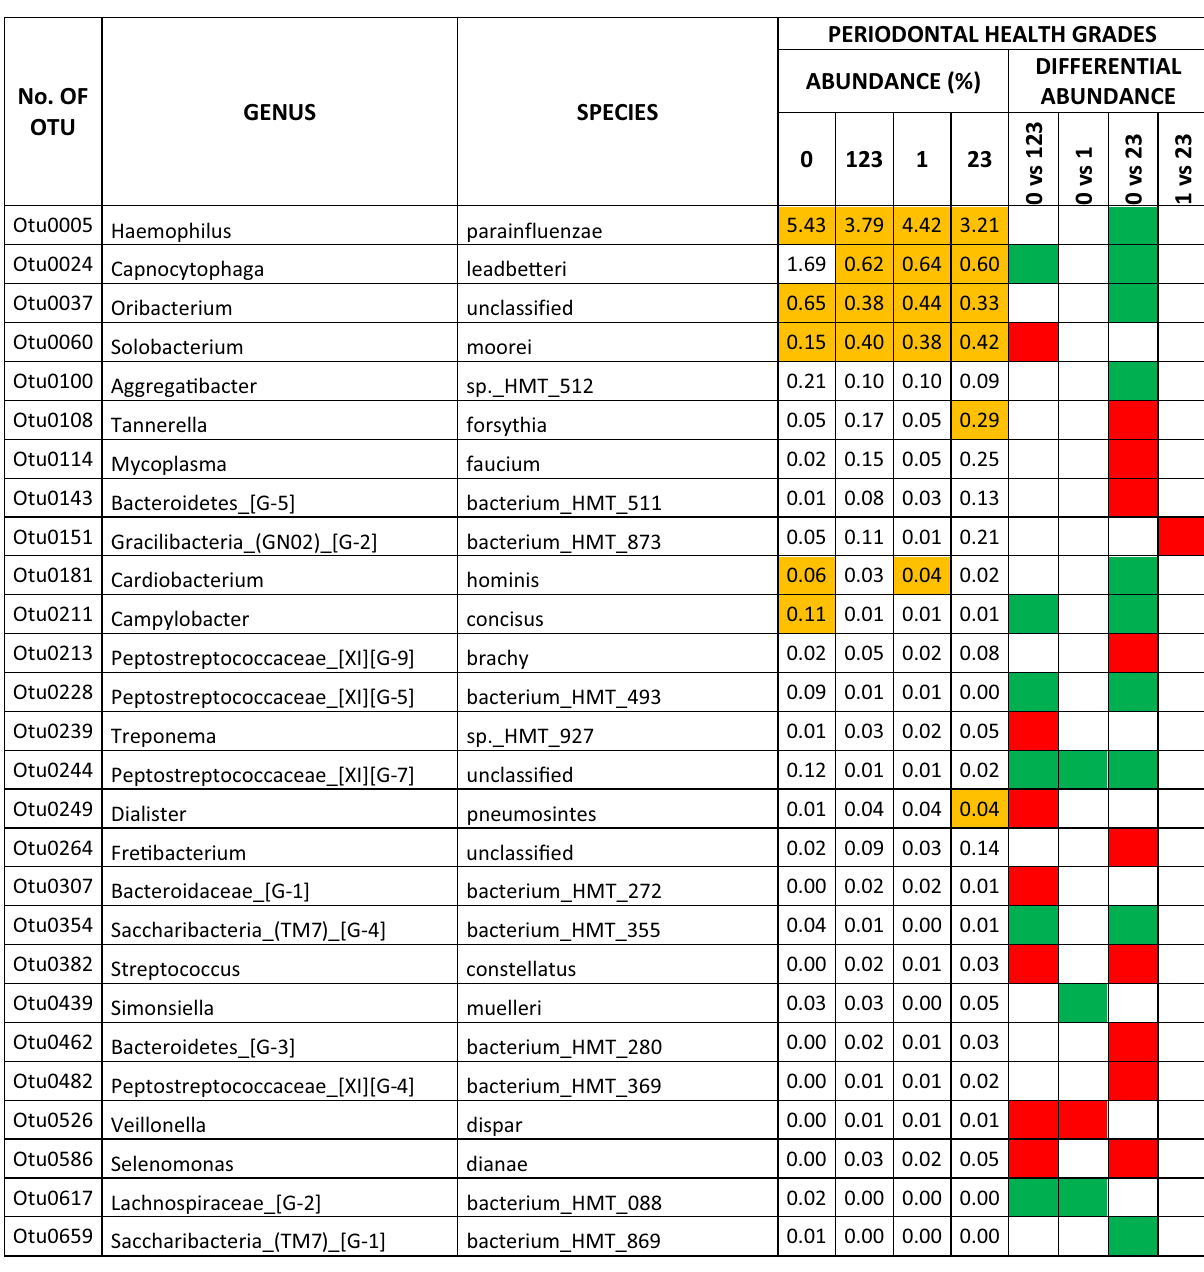
Table 4. Species that presented differential abundance among different grades of periodontal health (green square, in favour of health; red square, in favour of pathology). The species that belonged to the core are colored